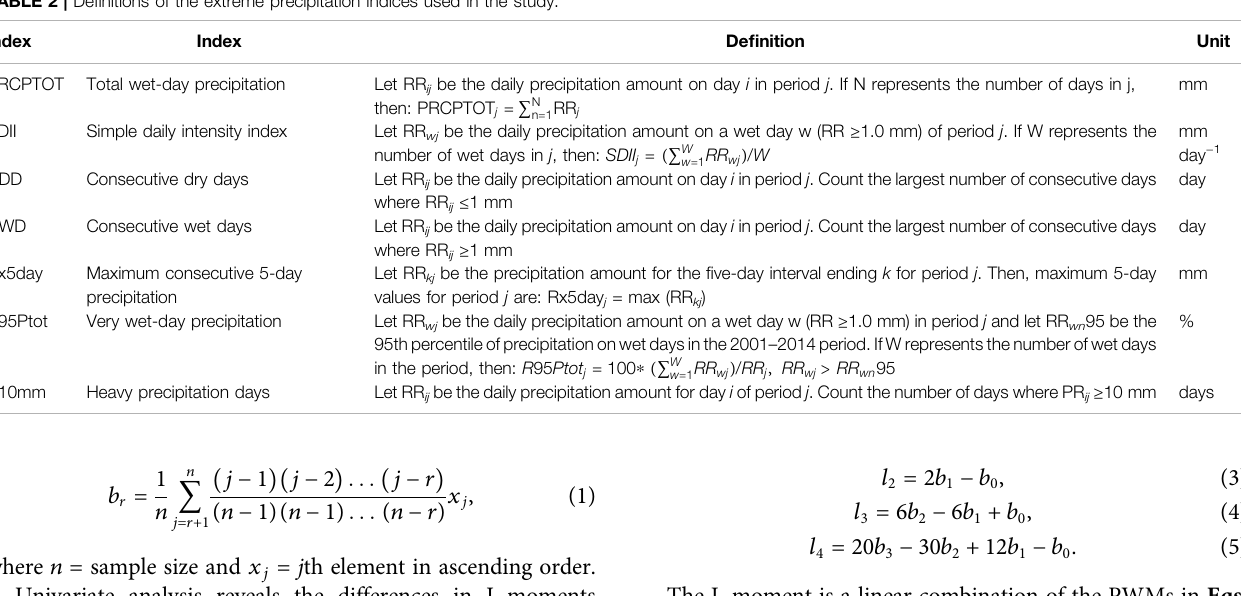
TABLE 2 | De fi nitions of the extreme precipitation indices used in the